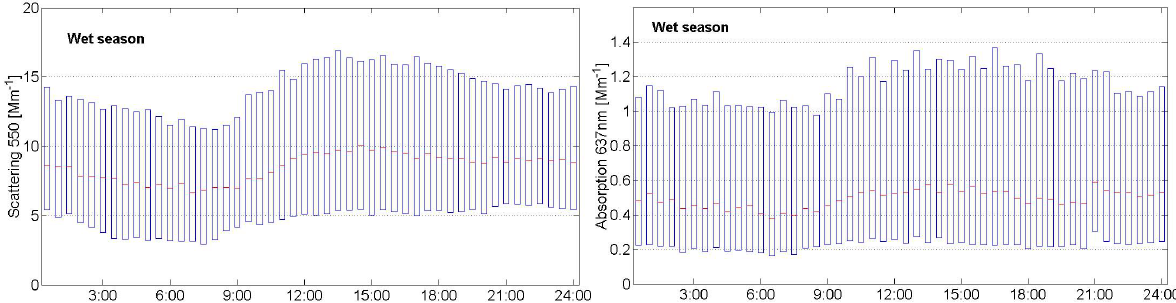
Fig. 9. Local time diurnal cycle boxplots for wet season (a) aerosol particle scattering at 550nm; (b) aerosol particle absorption at 637nm. The box lines represent the lower quartile, median, and upper quartile values.